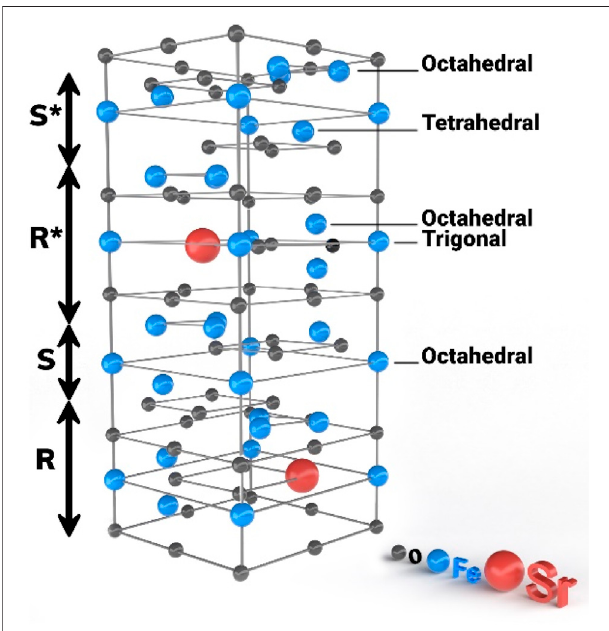
FIGURE 1 | Unit cell of SrM (contain S block and R